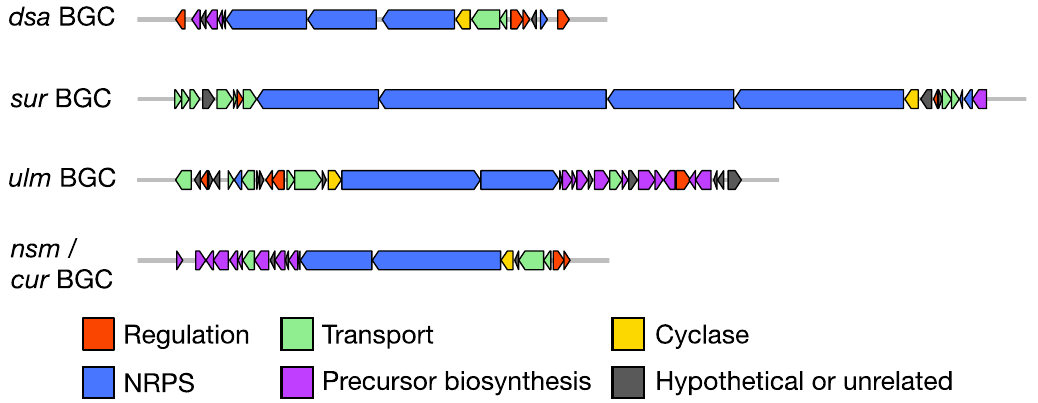
Figure 2. Biosynthetic gene clusters (BGCs) of the desotamide family of antibiotics. BGCs are drawn to relative scale. Colour-coding denotes deduced functionality of gene products. dsa = desotamide, sur = surugamide, ulm = ulleungmycin, nsm = noursamycin, cur = curacomycin.